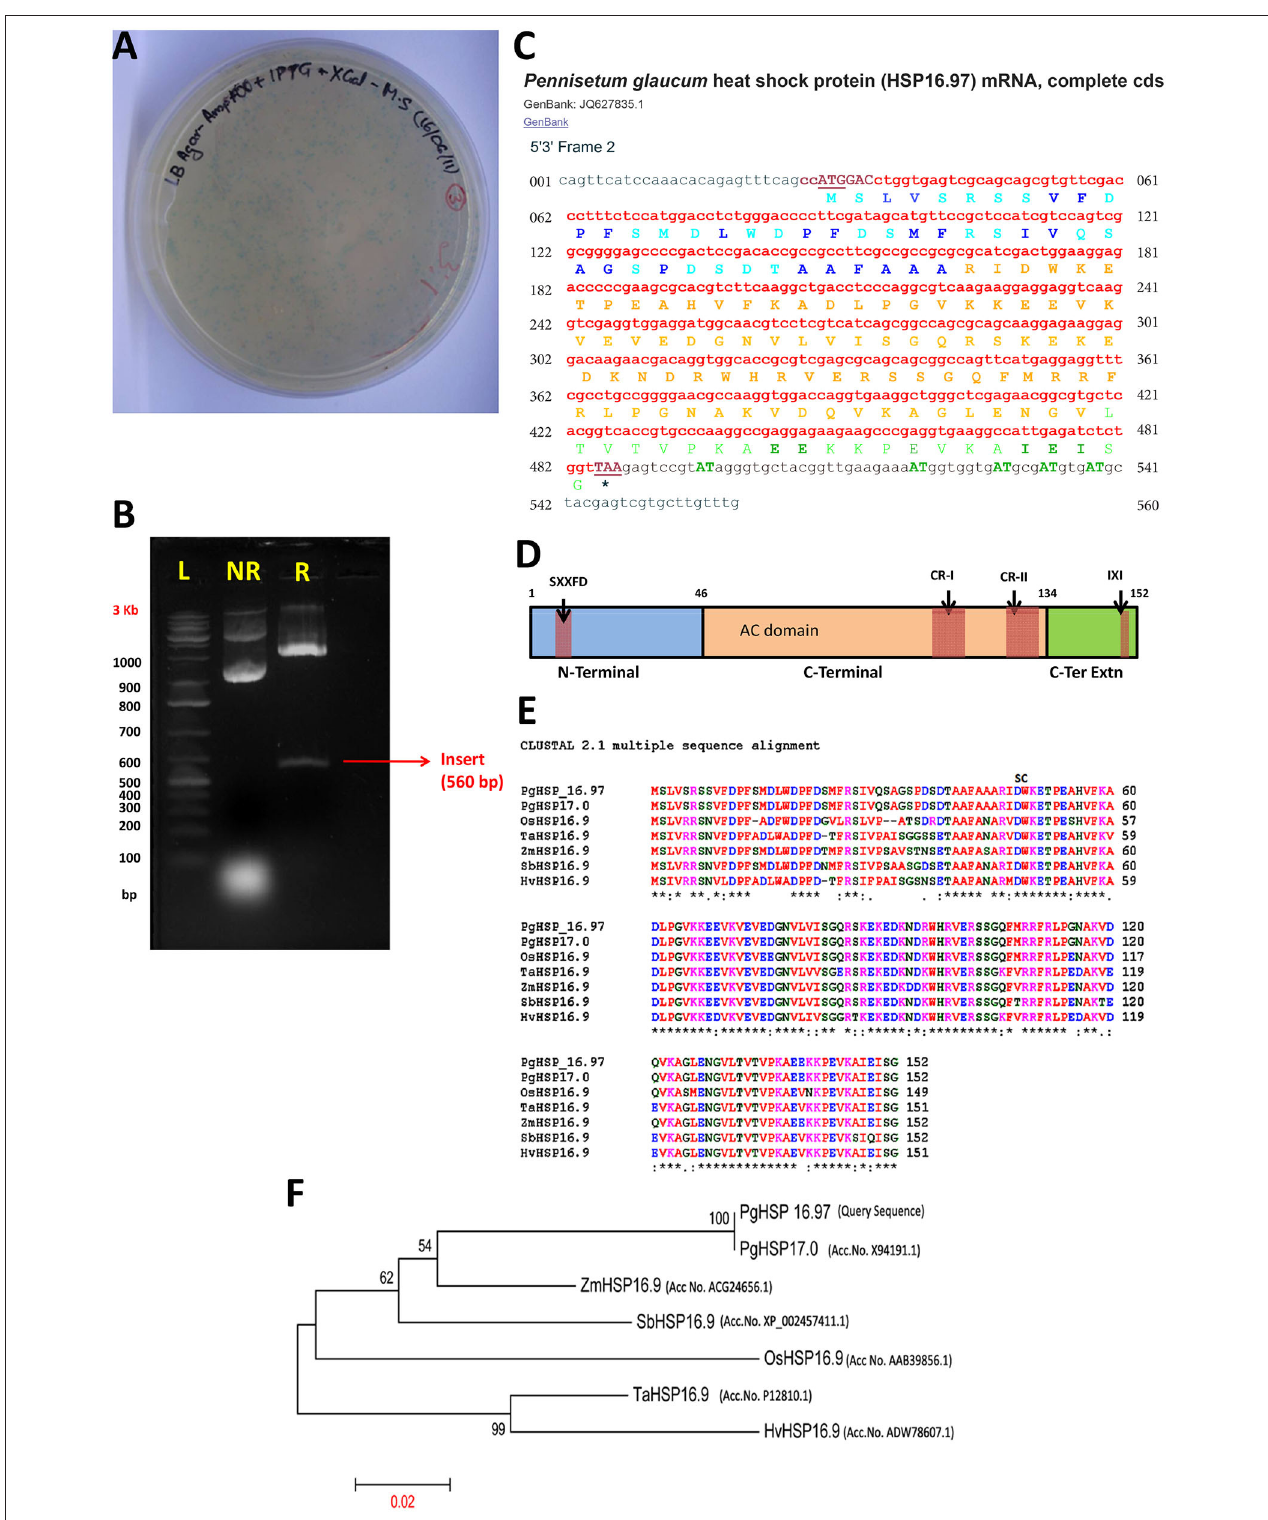
FIGURE 3 | Cloning, validation, and structural analysis of PgHSP16.97 . (A) Blue-white screening of positive cloning of insert. The PgHSP16.97 gene was eluted from agarose gel and cloned onto pGEM®-T easy cloning vector. The transformed cell culture was plated onto LB agar plates containing ampicillin, IPTG, and X-Gal